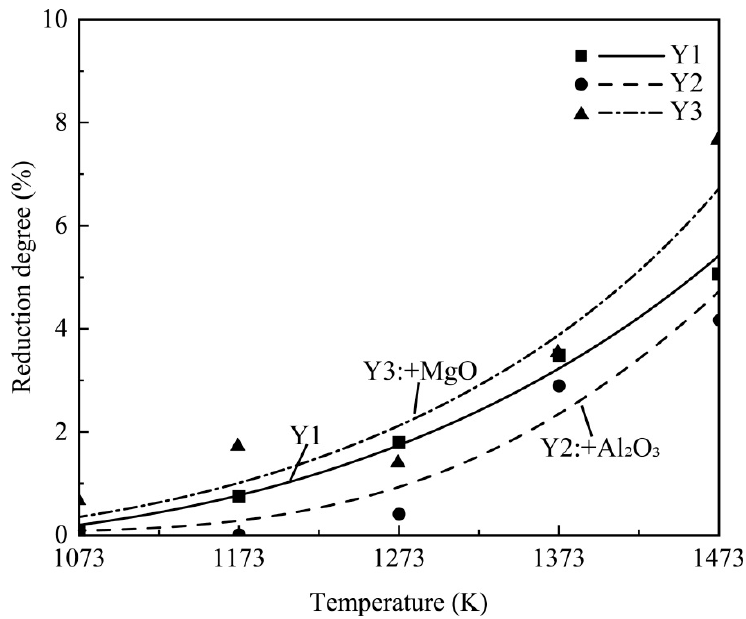
Figure 6. Comparison of reduction degree of three slags after 50 s reaction; the symbols are experi- mental results and the lines are data fitting.